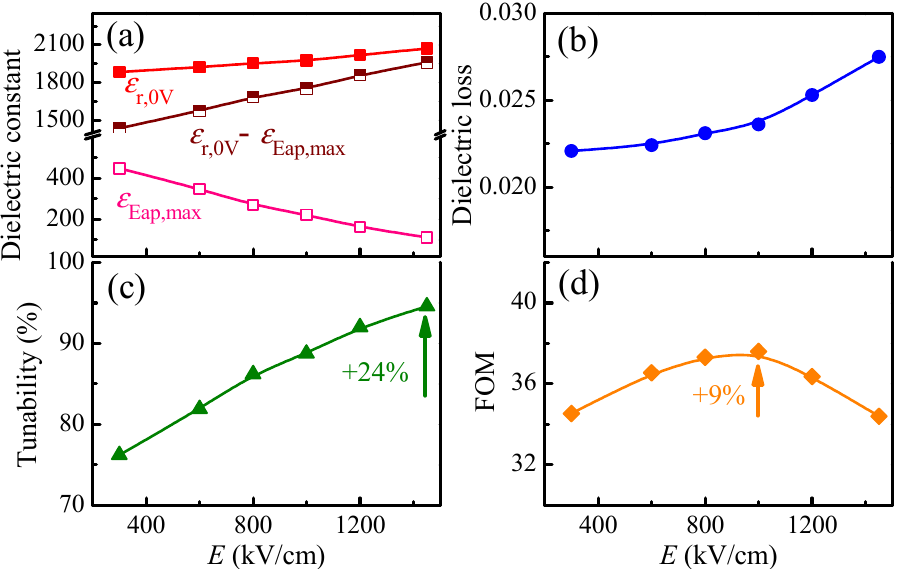
Figure 6. Applied electric-field dependent ( a ) dielectric constant at zero field ( ε r, 0 V ) and at certain bias field ( ε Eap,max ), ( b ) dielectric loss at zero field (tan δ ), ( c ) tunability ( T ) and ( d ) figure-of-merit ( FOM ), of 1000–nm PLZT films. The measurements were done at a frequency of 100 kHz.